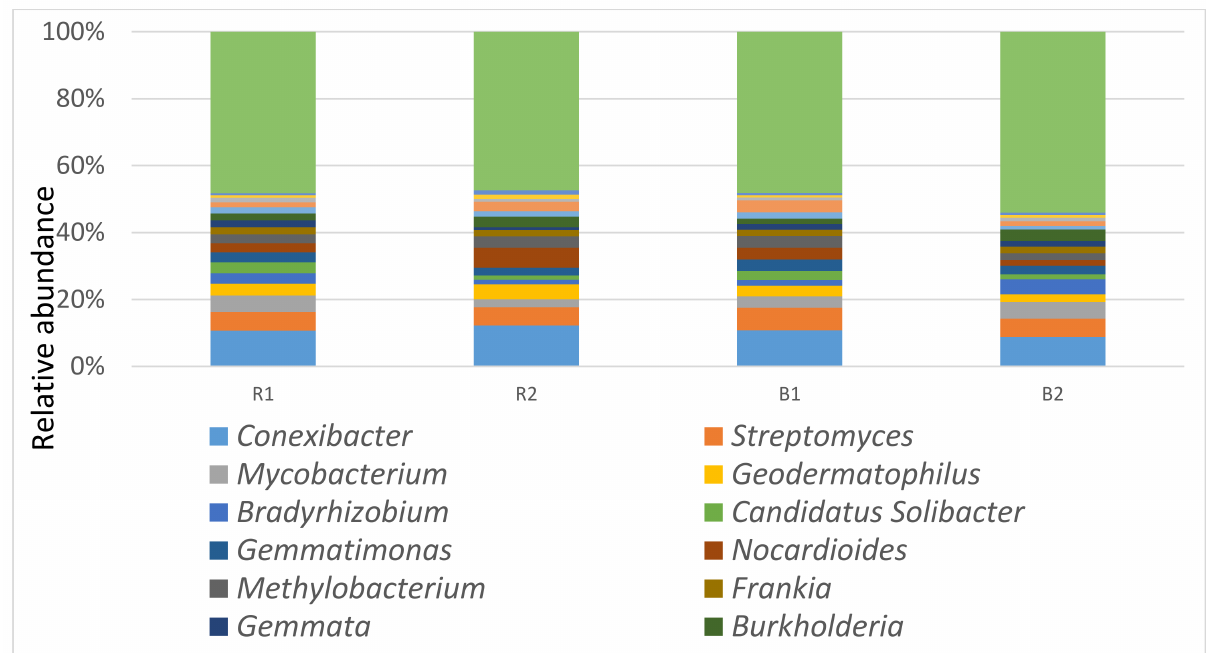
Figure 4. Classification of the most abundant genus observed using shotgun metagenomic sequences in the rhizosphere (R1 and R2) and bulk soil samples (B1 and B2) of two sunflower fields in South Africa, Palmietfontein (R1, B1) and Bloemhof (R2,